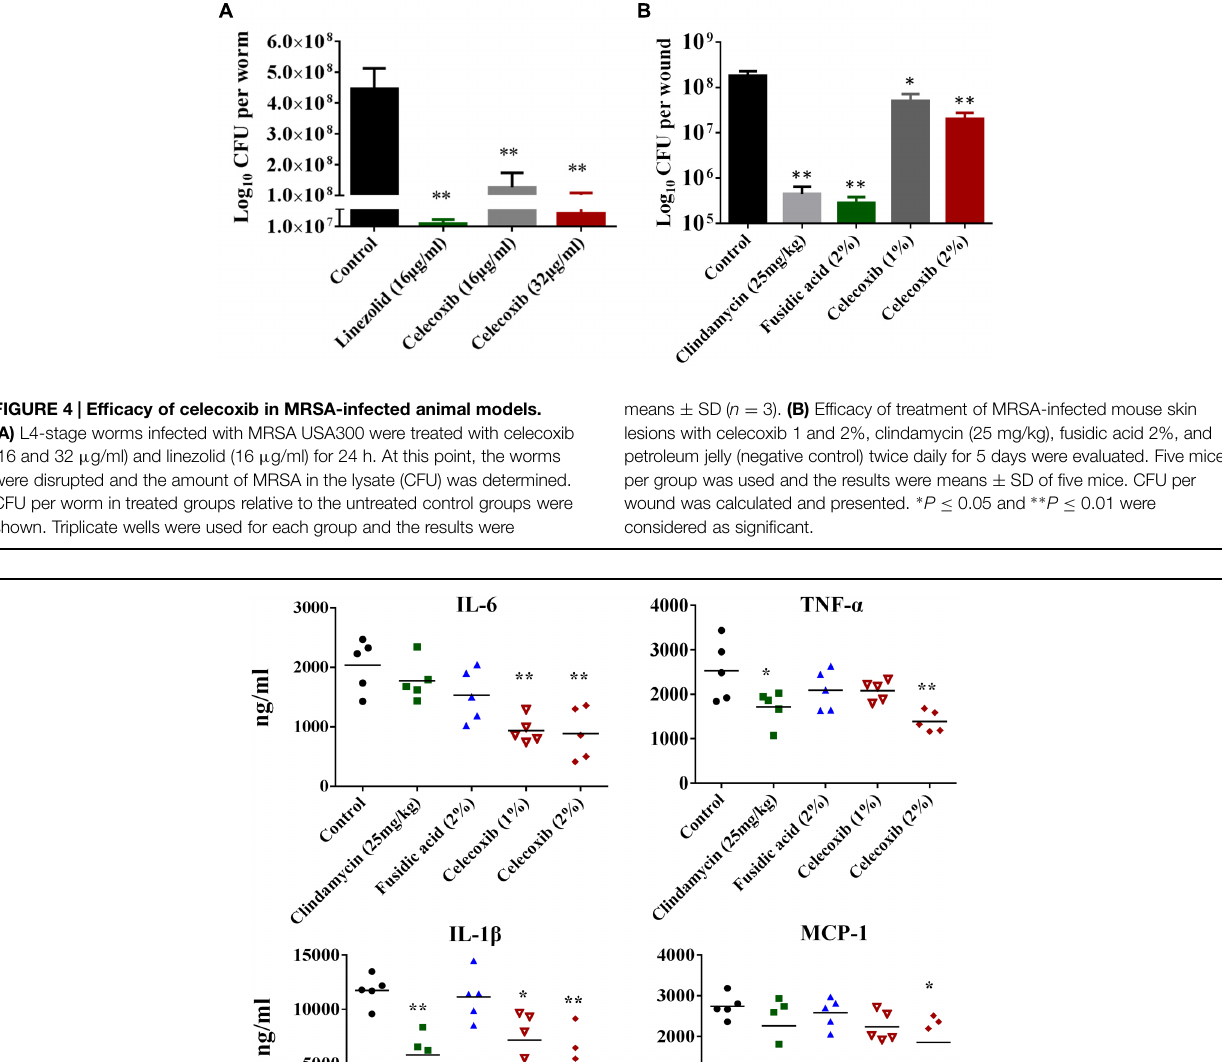
FIGURE 5 | Effect of celecoxib on IL-6, TNF- α , IL-1 β , and MCP-1 production in MRSA infected skin lesions. Supernatants from skin homogenates were used for cytokine detection by ELISA. Each point represents single mice and each group has five mice. Statistical analysis was calculated by the two-tailed